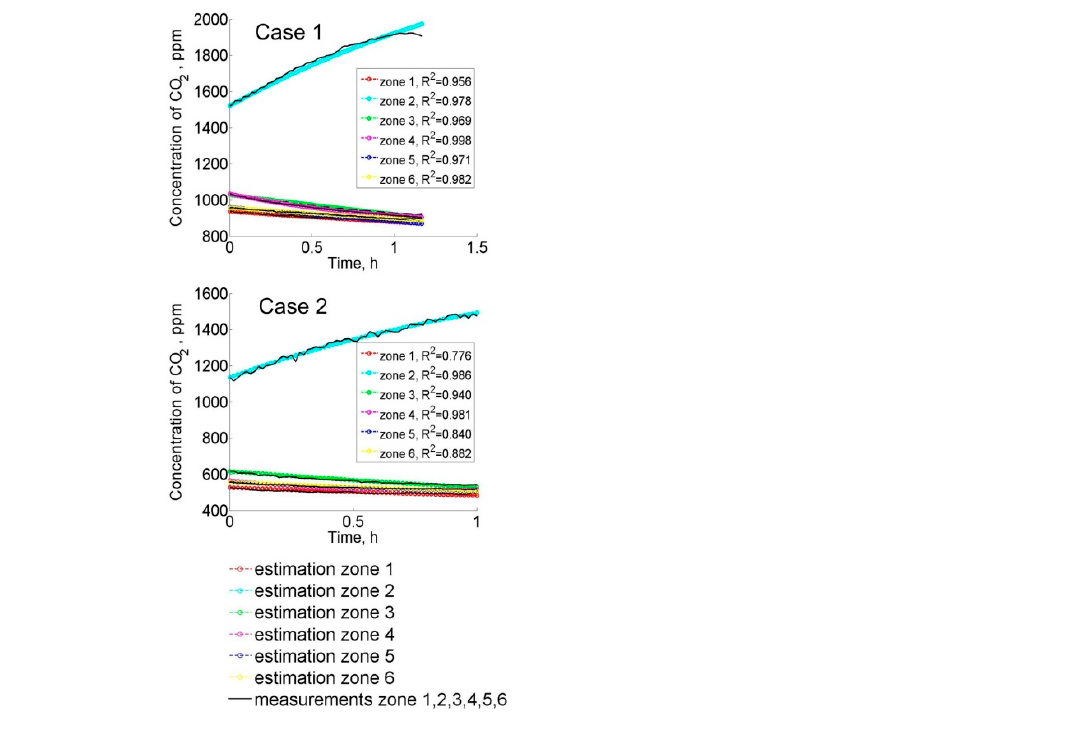
Figure 8. Fitting of the estimated and calculated curves of carbon dioxide concentration in apartment II for cases presented in Table 5.